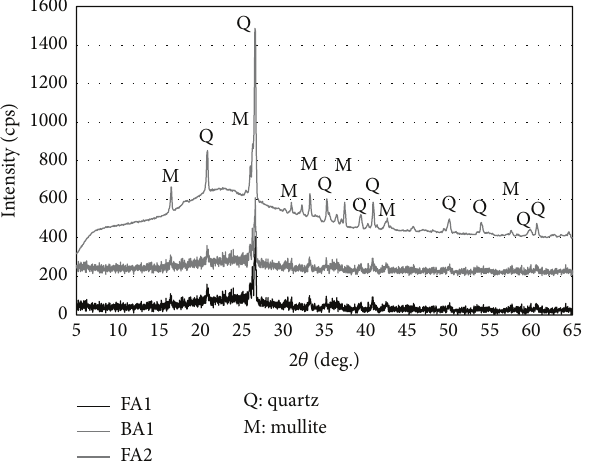
Figure 2: XRD patterns of the coal